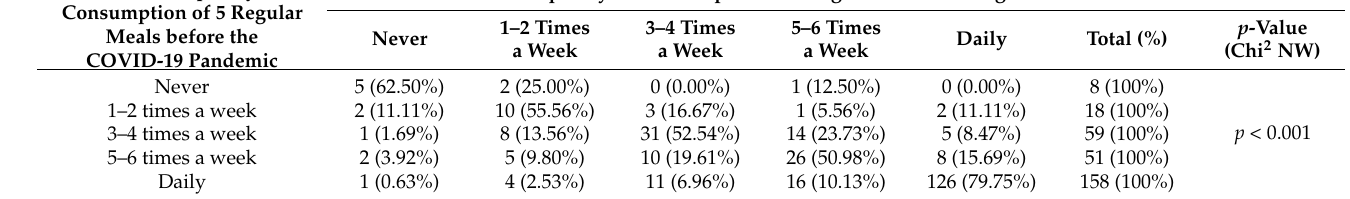
Table 2. Level of frequency of consumption of five regular meals per day before and during the COVID-19 pandemic.